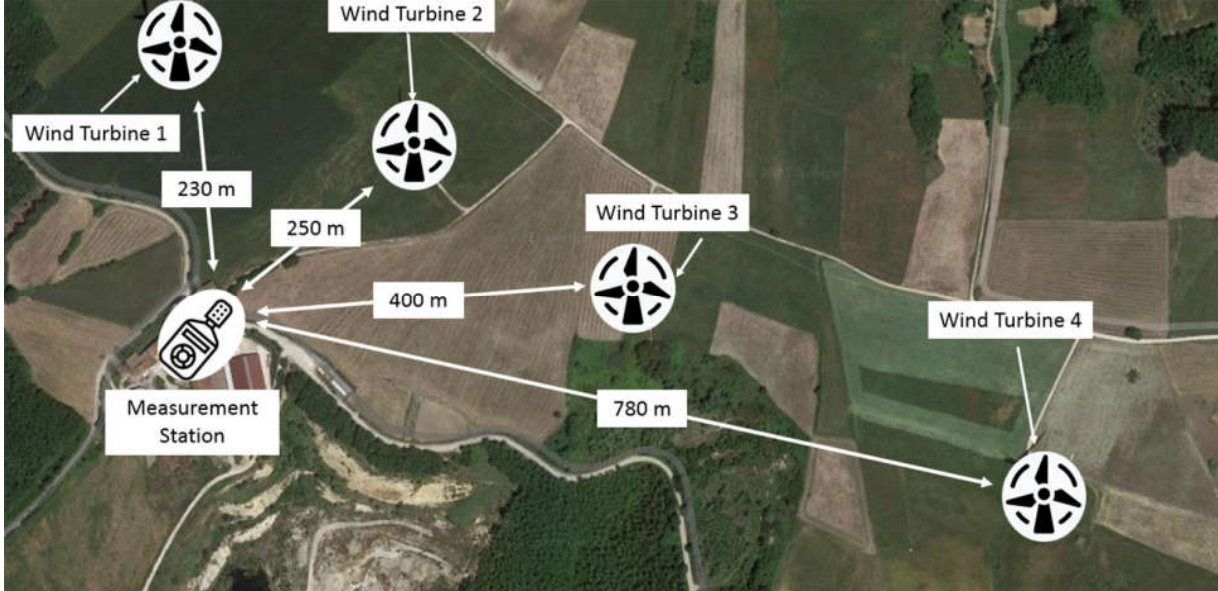
Figure 1. Map of the area where the wind farm is located, with indications of the position of the wind turbines and the measurement station. For each wind turbine, the distance that separates it from the measurement station has been added.